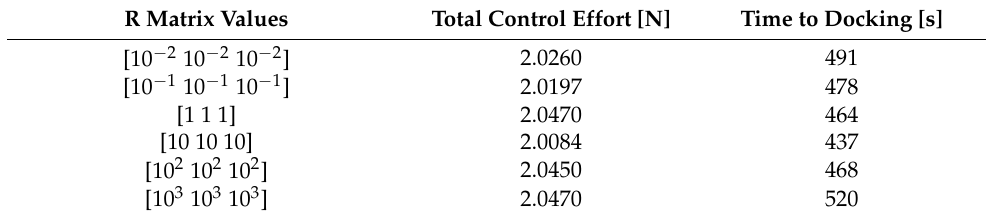
Table 3. Control effort related to Equation (14).